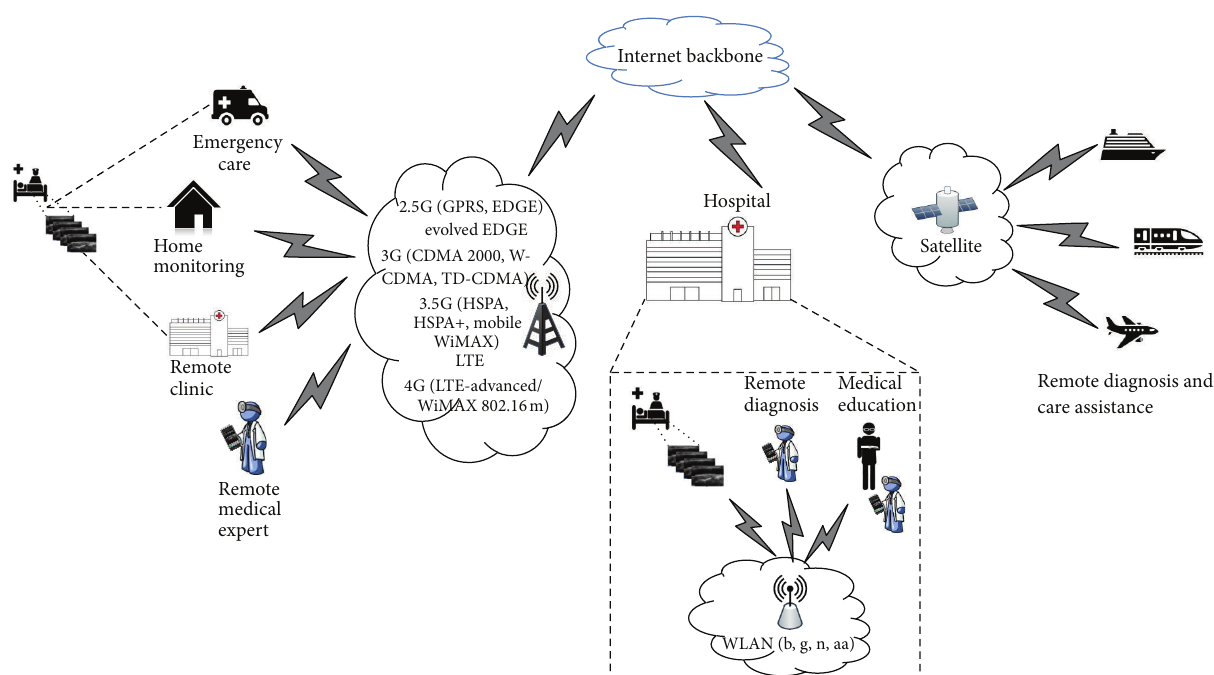
Figure 1: Typical scenarios for m-health medical video communication systems. Medical video is wirelessly transmitted based on the best available wireless network from the patient’s side to the medical expert’s end for remote